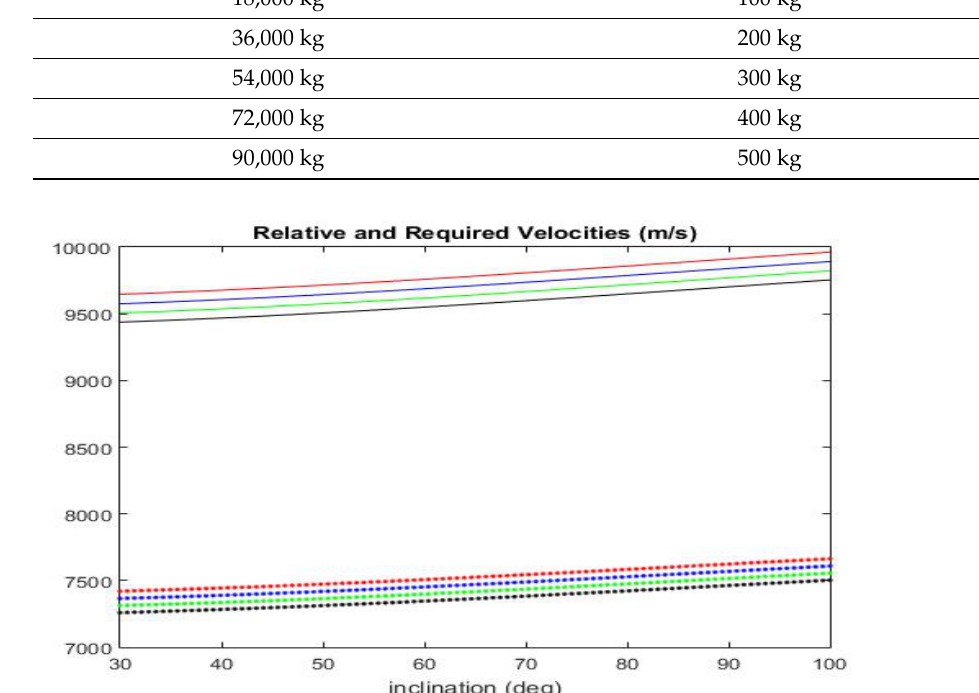
Figure 4. Therelative (dotted) and required (solid line) velocities to achieve circular orbits of altitude h = 800 km (black), 700 km (green), 600 km (blue), 500 km (red) and different